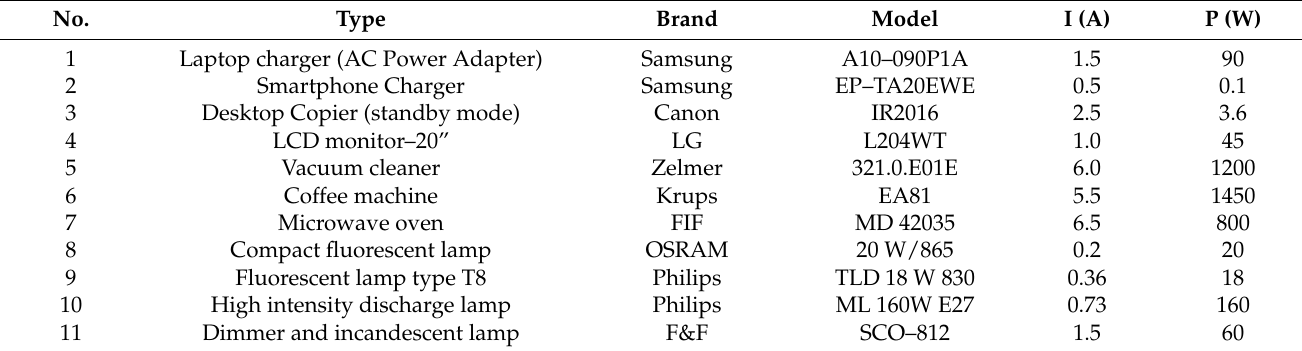
Table 1. Technical specifications of the selected